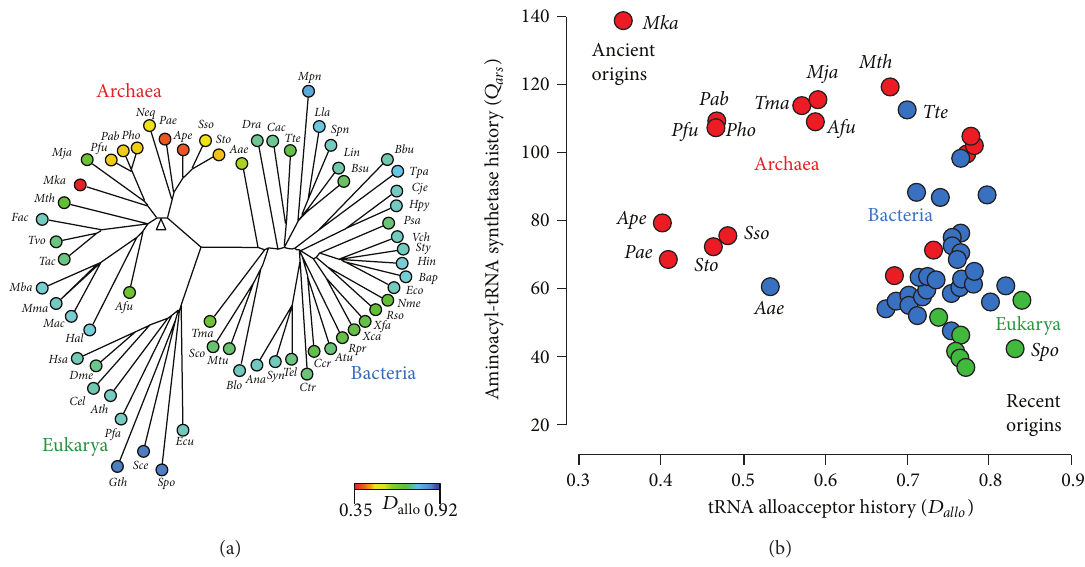
Figure 8: Ancient phylogenetic signal in the sequence of tRNA and their associated aminoacyl-tRNA synthetase (aaRS) enzymes. (a) distances traced in thermal scale (from [130]). 𝐷 Unrooted ToL derived from tRNA sequences with their alloacceptor 𝐷 allo of pairwise distances for 190 pairs of tRNA isoacceptors. These distances measure pairwise sequence mismatches of tRNAs for every genome and their values increase for faster evolving sequences of species of more recent origin. (b) Coevolution of aaRSs and their corresponding tRNA. Genetic distances between the top 10 potentially paralogous aaRS pairs estimated using BLASTP define a measure ( 𝑄 scores imply more ancestral and slowly evolving protein pairs. The plot the proteins resemble each other in genomes (from [131]). Larger 𝑄 ars scores against 𝐷 distances reveals a hidden correlation between the evolution of tRNA and aaRSs and the early origin of Archaea of 𝑄 ars allo and lower 𝐷 (larger 𝑄 ars allo